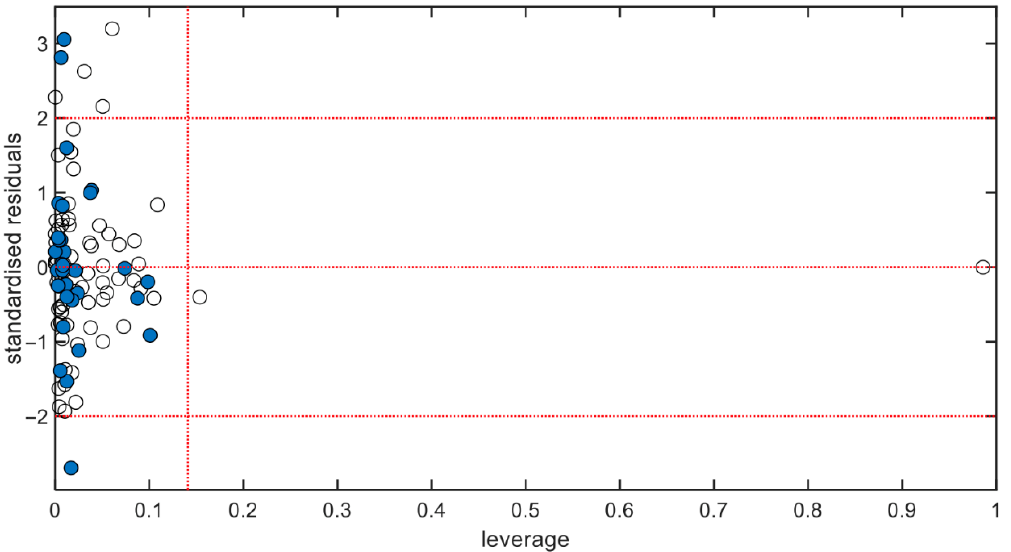
Figure 2. William plot for defining the applicability domain of the QSPR model. Training set mole- cules are labeled in black, and test set compounds are labeled in blue.